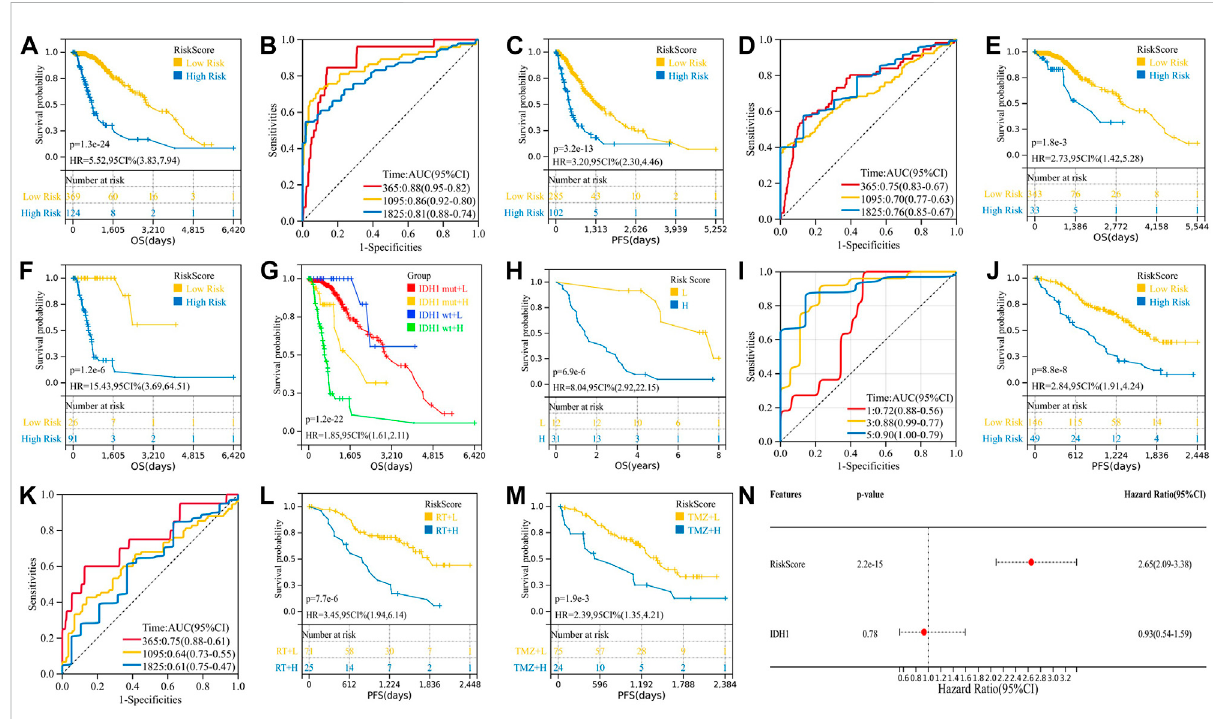
FIGURE 2 Validation of the two-gene risk model. (A) K-M survival curve for OS of TCGA cohort; (B) ROC curve for OS of TCGA cohort; (C) K-M survival curve for PFS of TCGA cohort; (D) ROC curve for PFS of TCGA cohort; (E) high-risk patients in the IDH1-mut group have shorter OS; (F) high-risk patients in the IDH1-wt group have shorter OS; (G) K-M curve combining the IDH1 mutation status and risk score; (H – I) validation of the two-gene risk model in GSE43388; (J – M) validation of the two-gene risk model in GSE107850; and (N) multivariate analysis of IDH1 and risk